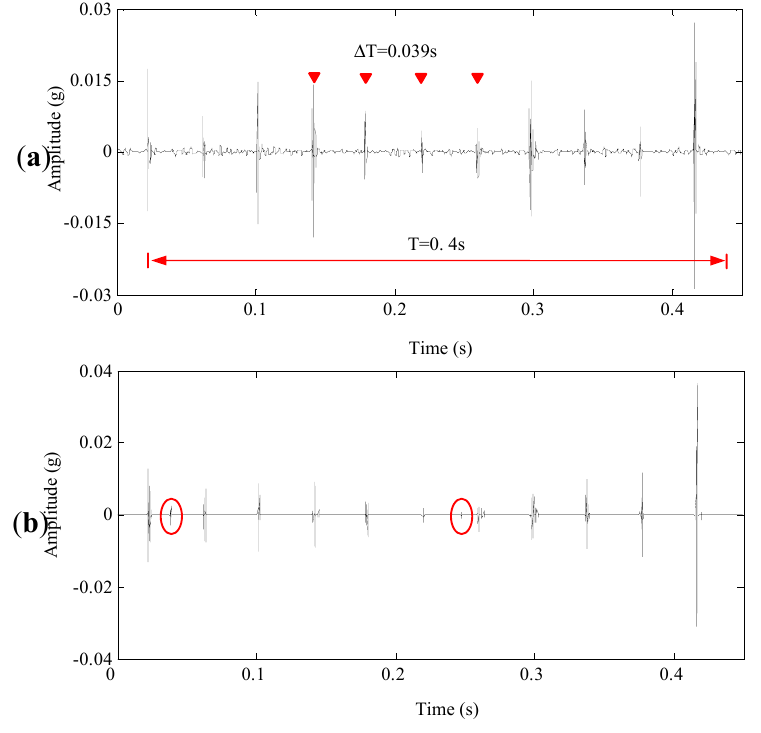
Figure 11. The denoising results of the normal planetary gearbox signal using the customized multiwavelet. ( a ) The proposed method ( b ) Conventional neighboring coefficients.